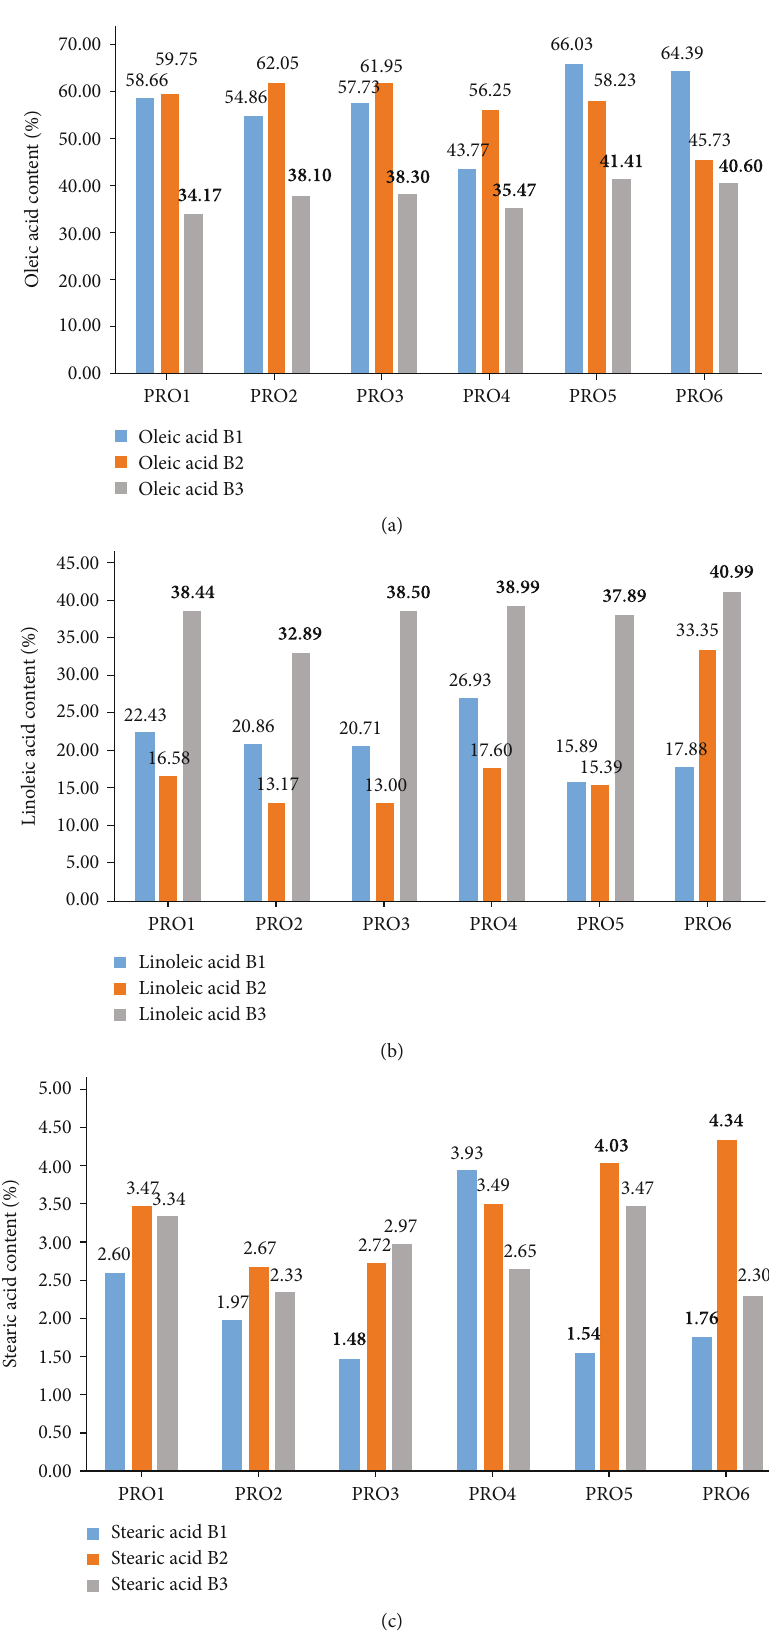
Figure 3: The statistical di ff erences observed for oleic acid (C18:1), linoleic acid (C18:2), and stearic acid (C18:0) within successive producer batches ( p ≤ 0 : 05 ): (a) oleic acid variation within batches, (b) linoleic acid variation within batches, and (c) stearic acid variation within